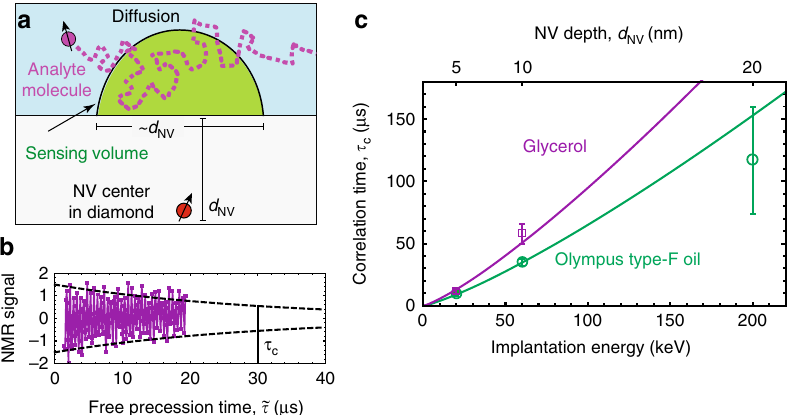
Fig. 6 Diffusion-limited NMR. a Diffusion of analyte molecules through the sensing volume. b Example of temporal decay of the correlation signal for immersion oil. The decay is exponential with a characteristic correlation time τ C . Dashed line represents the decay envelope. c Correlation time τ C as a function of nitrogen implantation energy for immersion oil and glycerol. Error bars represent fi t uncertainty. Solid lines are fi ts to the one-sided diffusion model discussed in the